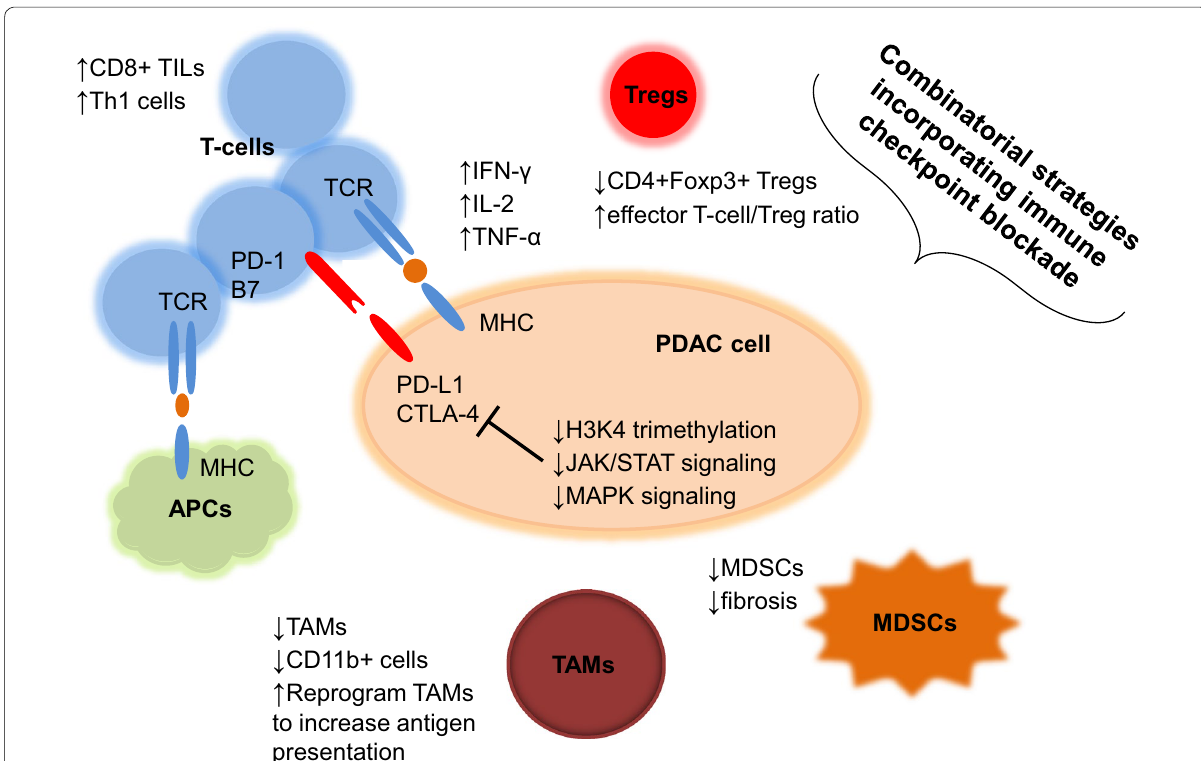
Fig. 1 Mechanisms of immune resistance to checkpoint blockade in pancreatic cancer. Preclinical evidence supports that combinatorial strategies incorporating checkpoint inhibitors can attenuate primary and acquired resistance to checkpoint blockade through multiple tumor cell-intrinsic and tumor cell-extrinsic mechanisms. For example, targeting of H3K4 trimethylation, JAK/STAT signaling, and mitogen-activated protein kinase (MAPK) signaling mitigates tumor cell-intrinsic upregulation of PD-L1 expression. Combination regimens with checkpoint blockade can also target tumor cell-extrinsic mechanisms of immune resistance by decreasing tumor-associated macrophages (TAMs) or reprogramming TAMs to increase antigen presentation and antitumor T-cell activity. MDSCs myeloid-derived suppressor cells, APCs antigen-presenting cells, MHC major histocompatibility complex, TCR T-cell antigen receptor, PD-1 programmed cell death protein 1 receptor, B7 B7 family of ligands, TILs tumor-infiltrating lymphocytes, PD-L1 programmed death ligand 1, CTLA-4 cytotoxic T-lymphocyte associated protein 4, IFNγ interferon-γ, IL-2 interleukin 2, TNF-α tumor necrosis factor alpha, Tregs regulatory